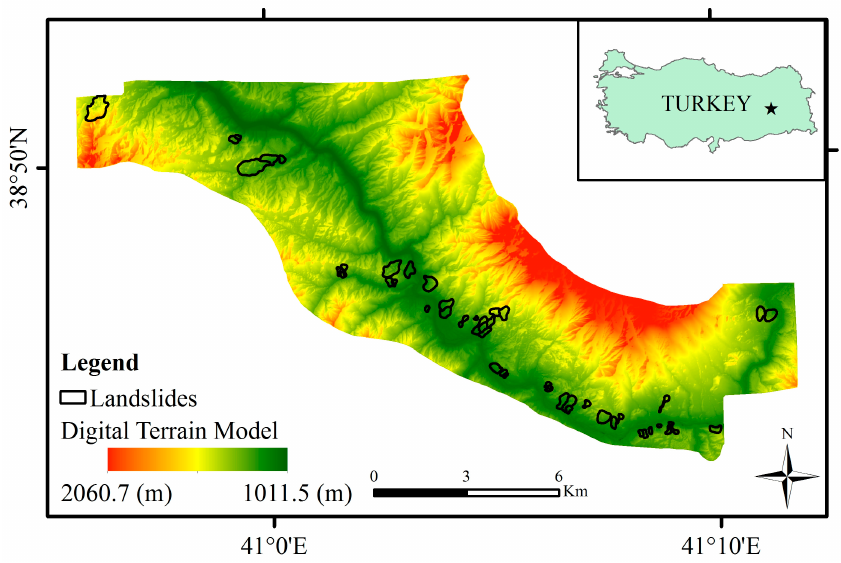
Figure 1. Color-coded digital terrain model (DTM) (from year 2012) of the study area and the landslides.